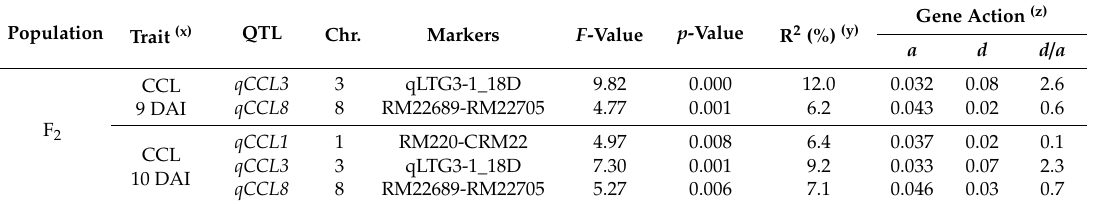
Table 4. List of QTLs identified for coleoptile length under low-temperature condition. Population